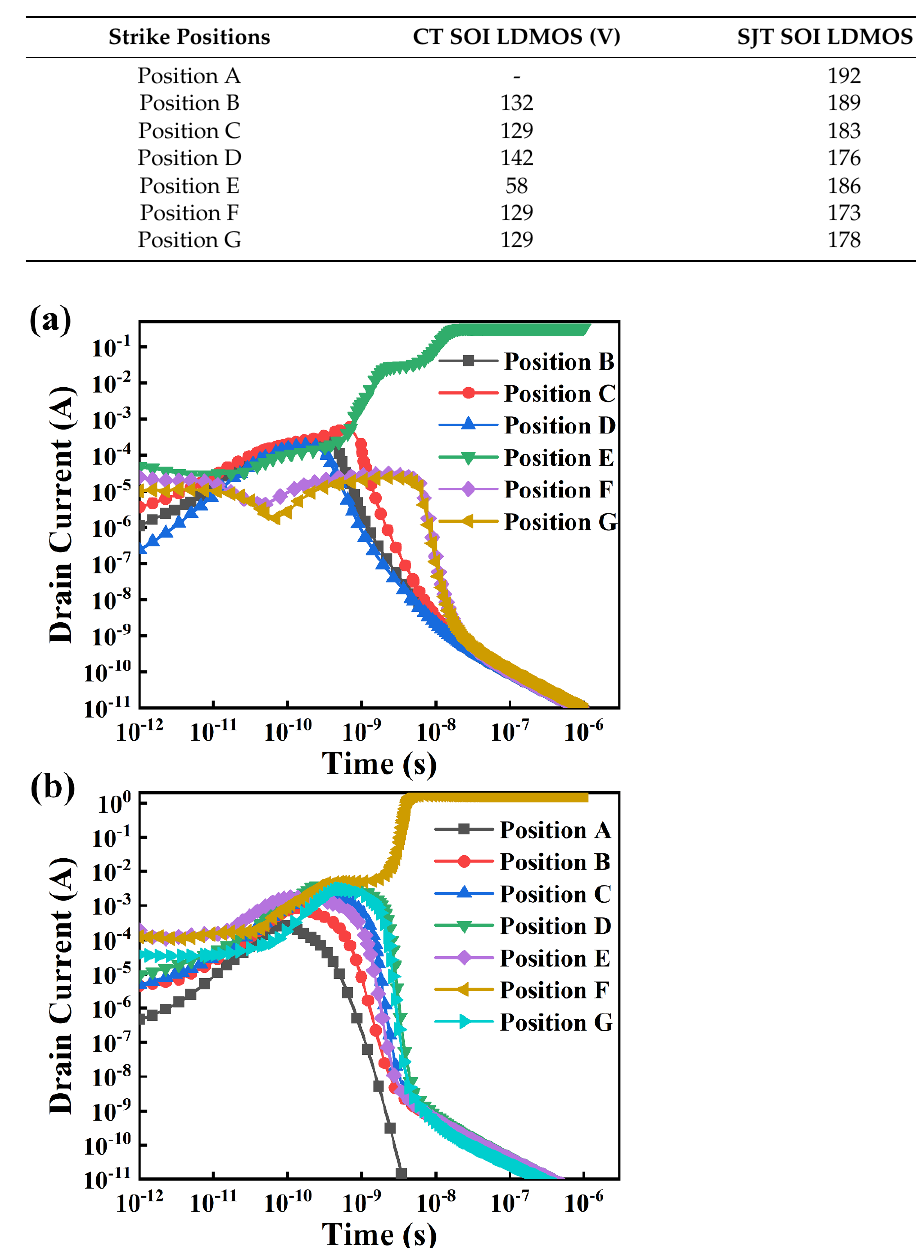
Table 3. The V SEB at different strike positions.